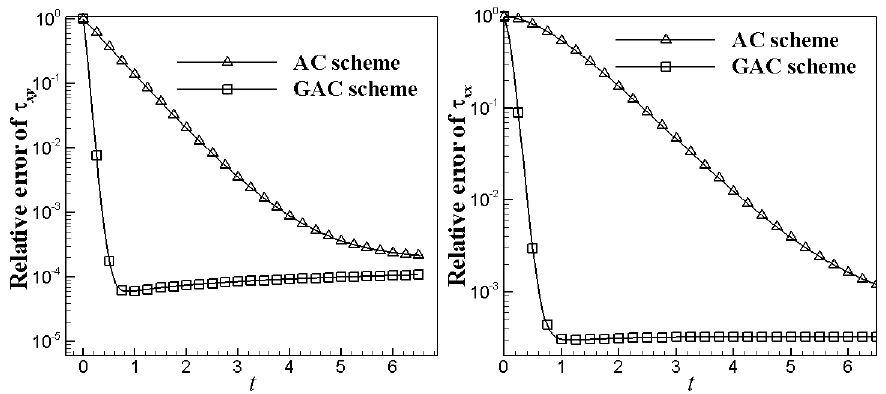
 and  for y at position x = 5 at Wi = 1.0 with xy xx